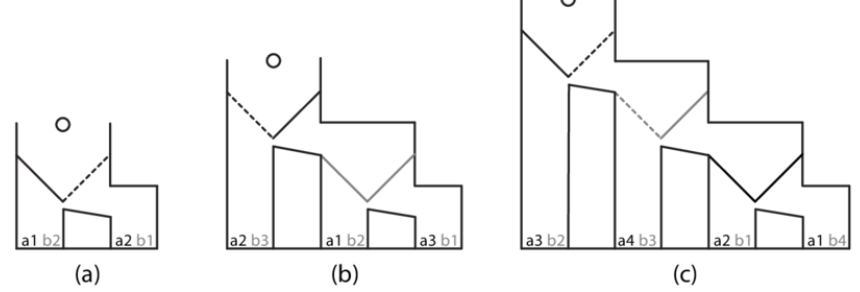
Figure 3. Marble Drop with rational opponent. Figures ( a ), ( b ) and ( c ) correspond to marble drop games of level 1, 2 and 3, respectively. Player 1’s payoffs are represented by a1, a2, a3, and a4, and Player 2’s payoffs by b1, b2, b3, and b4, both in increasing order of value. The goal for each player is to let the white marble end up in the bin with the highest attainable payoff. At the first set of diagonal trapdoors, Player 1 decides to remove the left or right trapdoor, at the second set Player 2 decides, and at the third set Player 1 decides. Dashed lines represent the trapdoors that both players should rationally remove for these payoff